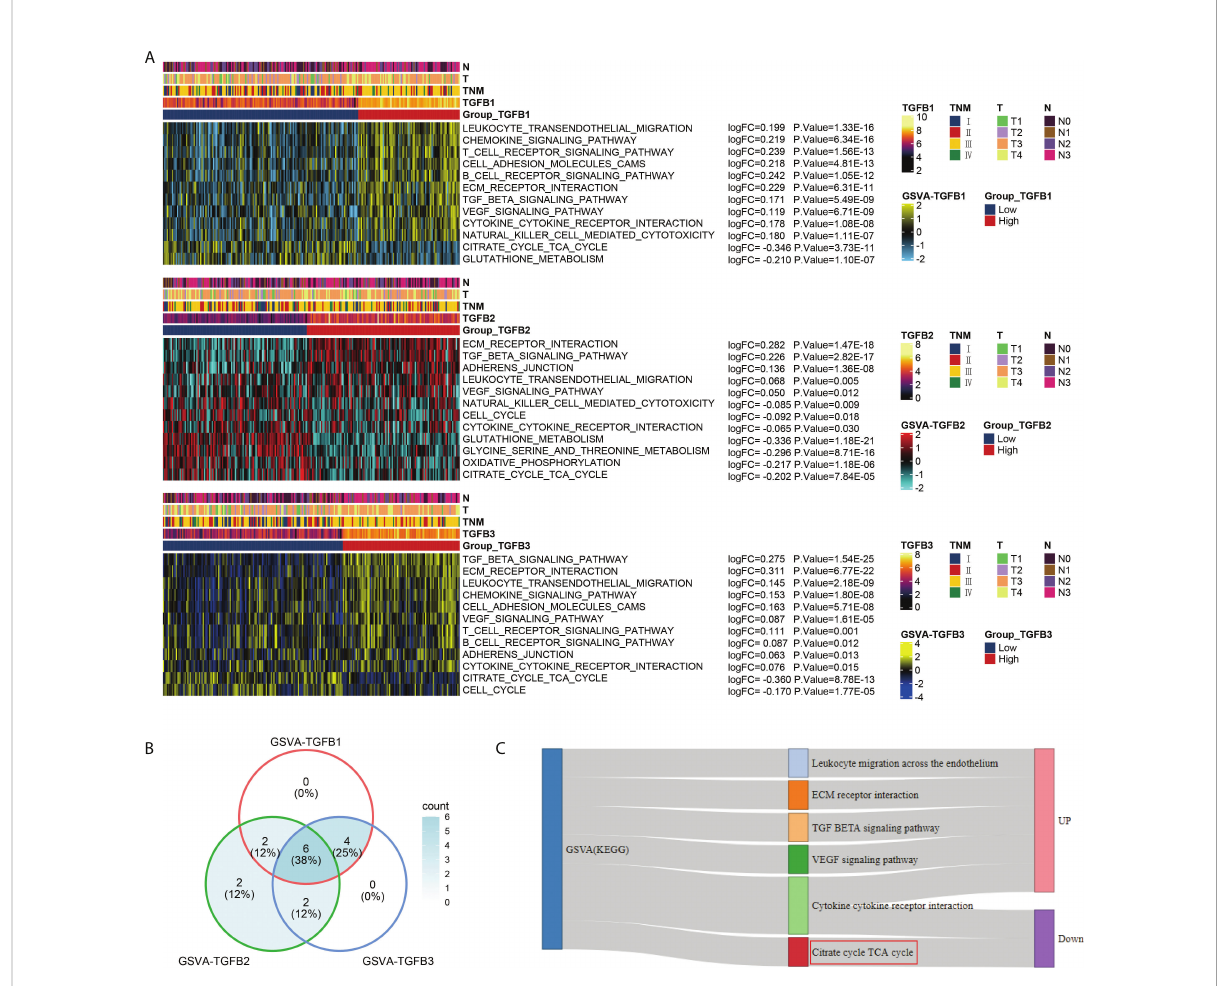
FIGURE 4 Functional enrichment analysis of different TGF b groupings. (A) Heatmaps were used to visualize biological processes across different TGF b 1, TGF b 2 and TGF b 3 groupings. (B) Venn diagram showing the intersection of differential functional pathways between different TGF b groupings in the dataset GSE184336. (C) Sankey diagram showing the expression of 6 intersecting